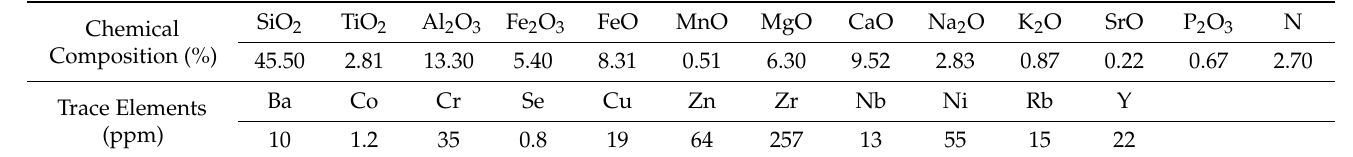
Table 4. Chemical composition of Nano-Zeolite after loaded nitrogen.